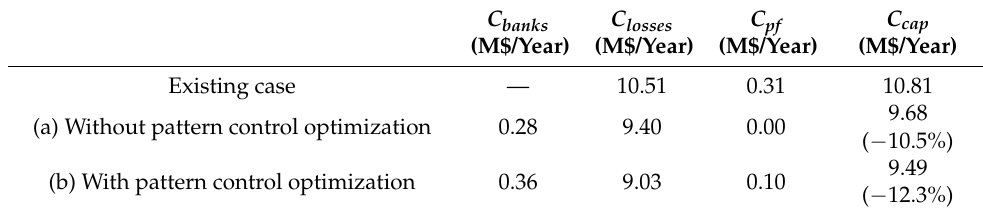
Table 6. OF values for the optimal placement capacitor bank unit performed for the case